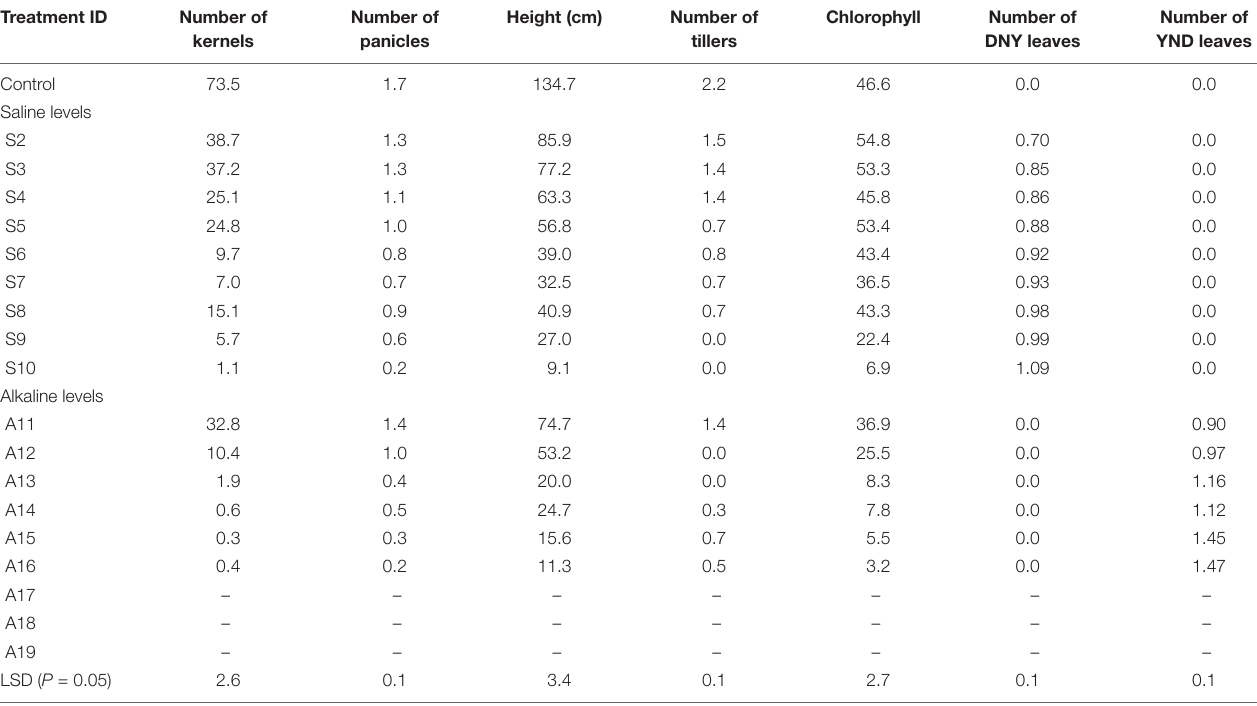
TABLE 7 | The mean values of plant height, chlorophyll content, and numbers of tillers, panicles, DNY leaves, YND leaves, and grains per plant under different salinity and alkalinity levels. Treatment ID Number of Number of Height (cm) Number of Chlorophyll Number of Number of kernels panicles tillers DNY leaves YND